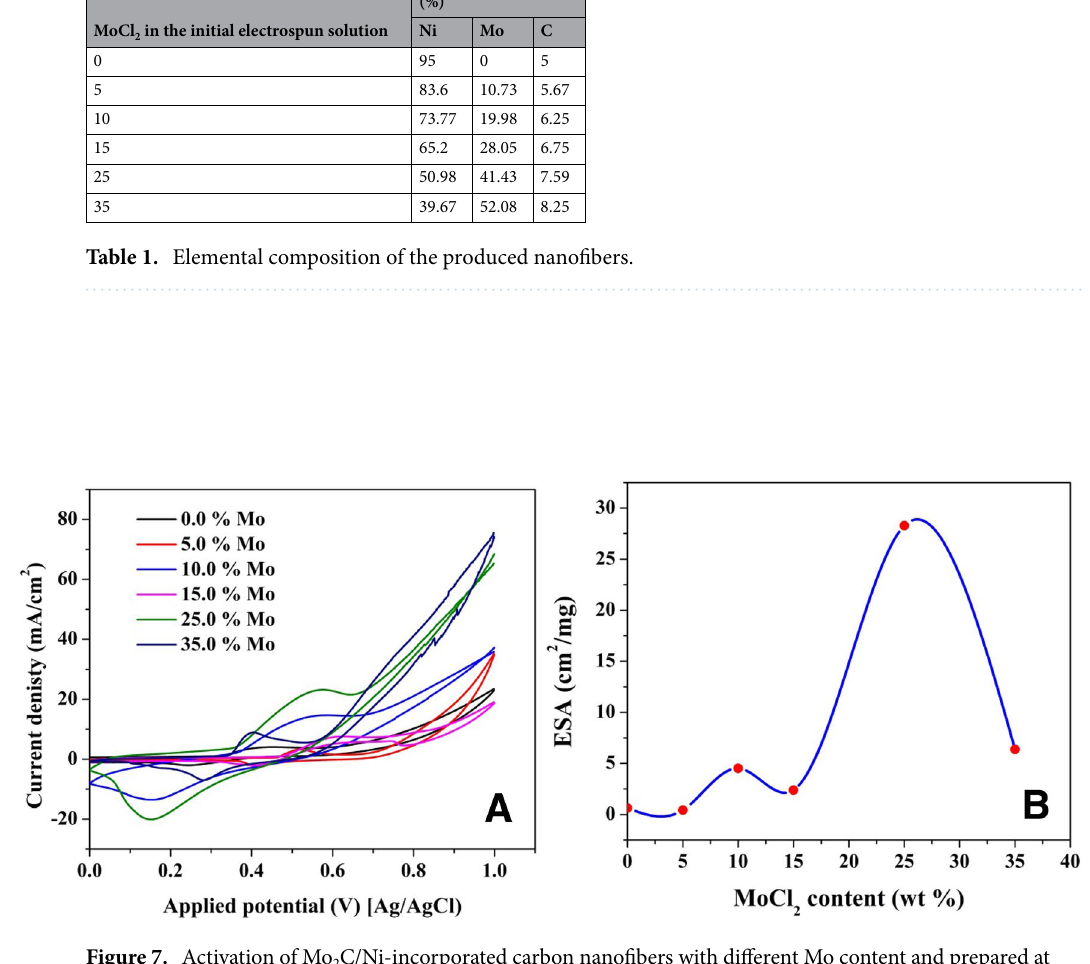
MoCl 2 in the initial electrospun solution